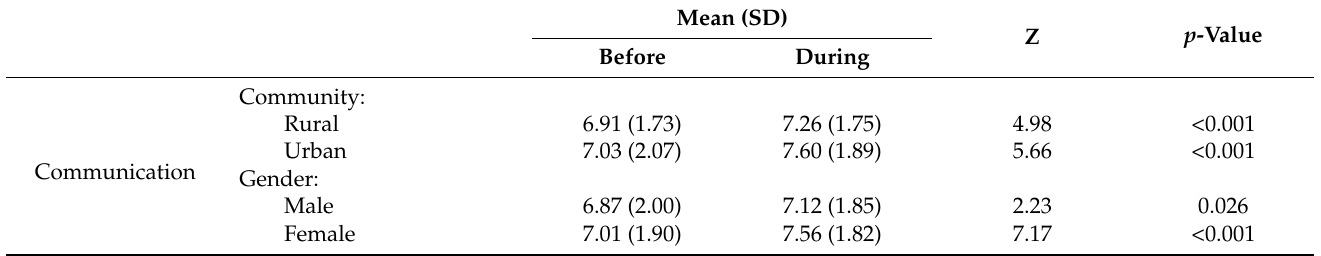
Table A4. Frequency in Using a Mobile Device before and during the COVID-19